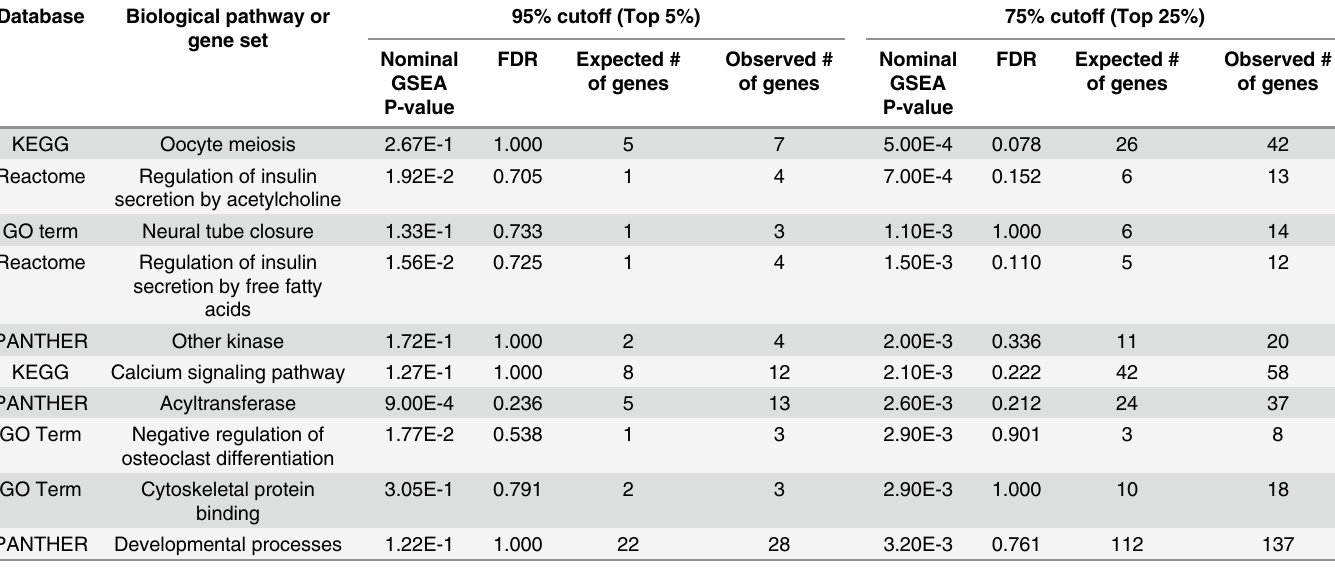
Table 2. Top ten significant biological pathways or gene sets associated with polycystic ovary